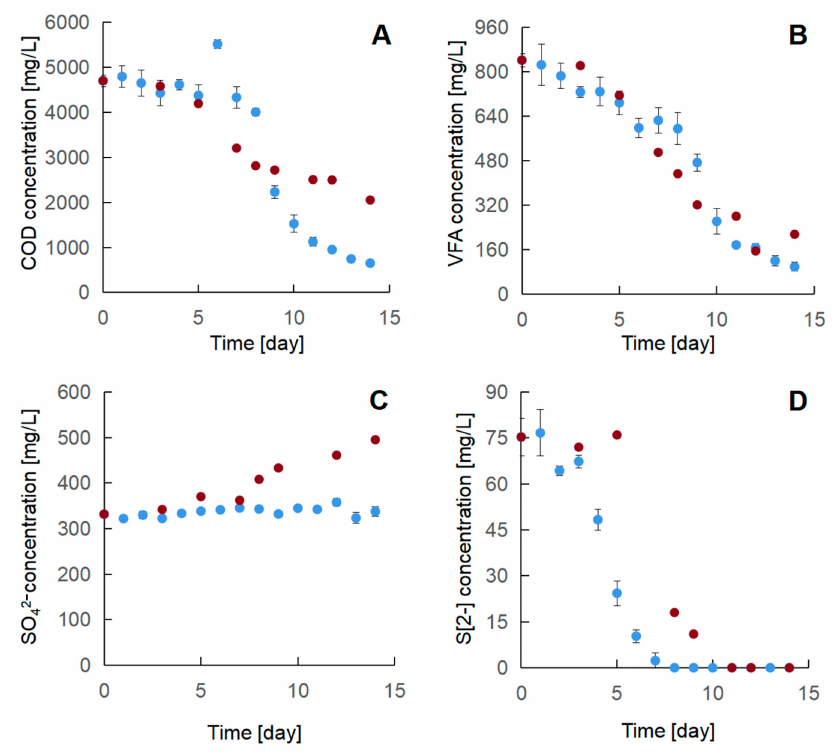
Figure 6. Changes in chemical parameters as a function of time within 14 days of two-stage bio- oxidation and control experiment: ( A ) COD; ( B ) VFAs; ( C ) SO 42 − ; ( D ) S 2 − . Blue dots refer to data of bio-oxidation using SOB and Bioremoil. Red dots refer control without adding microbial consortia (saturation of the solution with oxygen was kept at 1%from day 0 to 5), then, oxygen level was increased and saturation of the solution with oxygen was kept at 100% from day 6 to 14. Day 0—Inoculation of SOB; day 6—Inoculation of